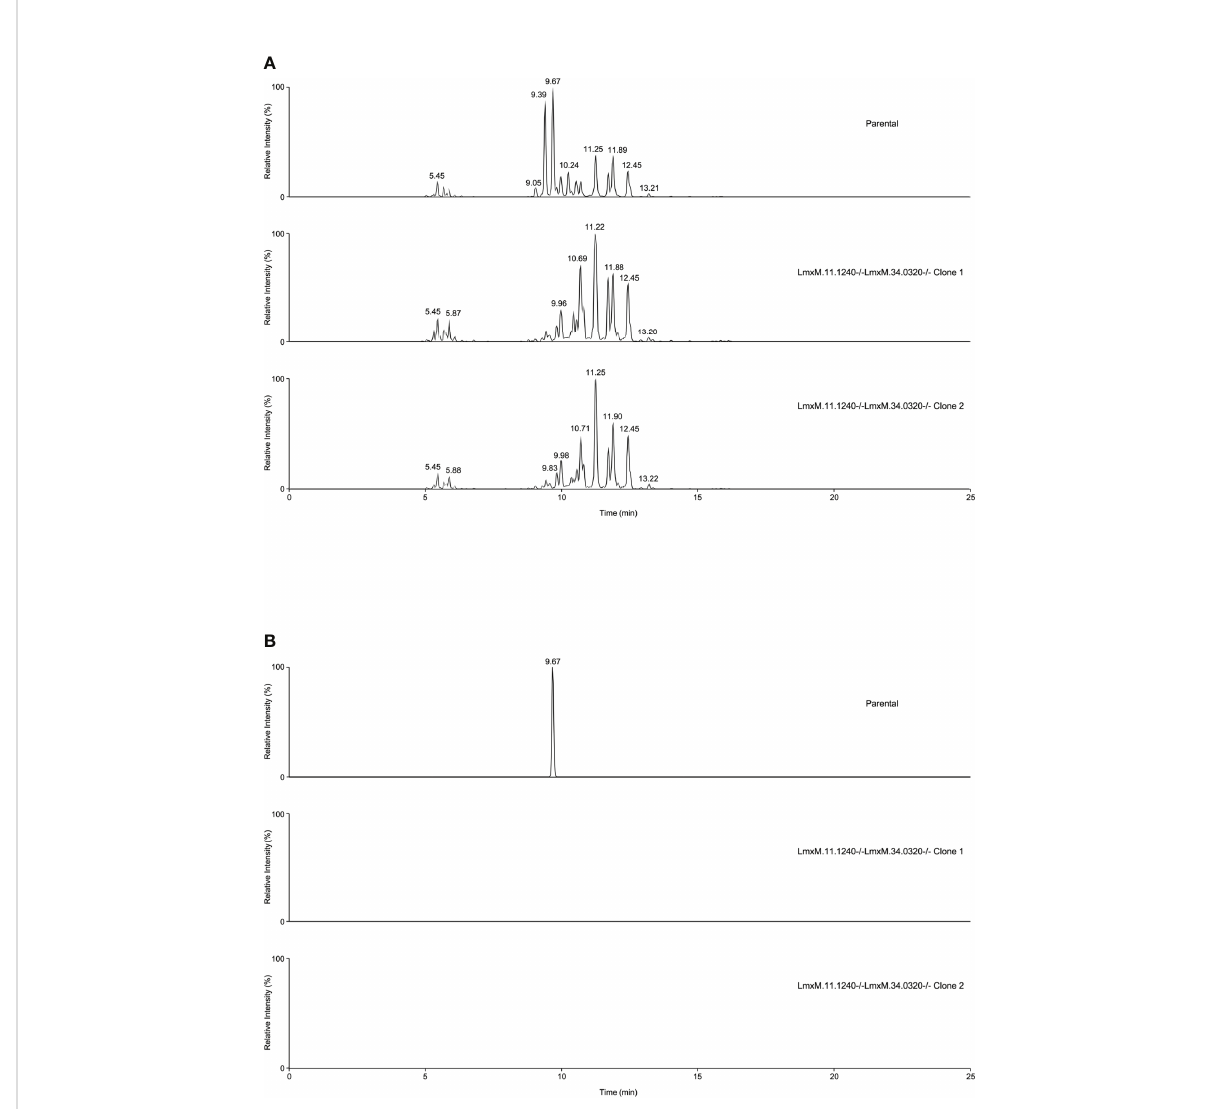
FIGURE 6 Global lipidomic analysis of LmxM.11.1240 and LmxM.34.0320 double knockout (LmxM.11.1240-/-LmxM.34.0320-/-) clones 1 and 2, and the parental line, L. mexicana strain T7 Cas9. Panel A shows exemplar negative ion mode LC-MS chromatograms of lipid pro fi les; Panel B shows extracted ion chromatograms attributable to the [M-H] - ion of IPC 34:0:2 (m/z